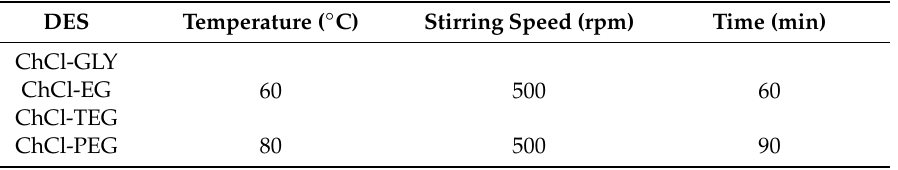
Table 1. Deep eutectic solvent (DES) preparation